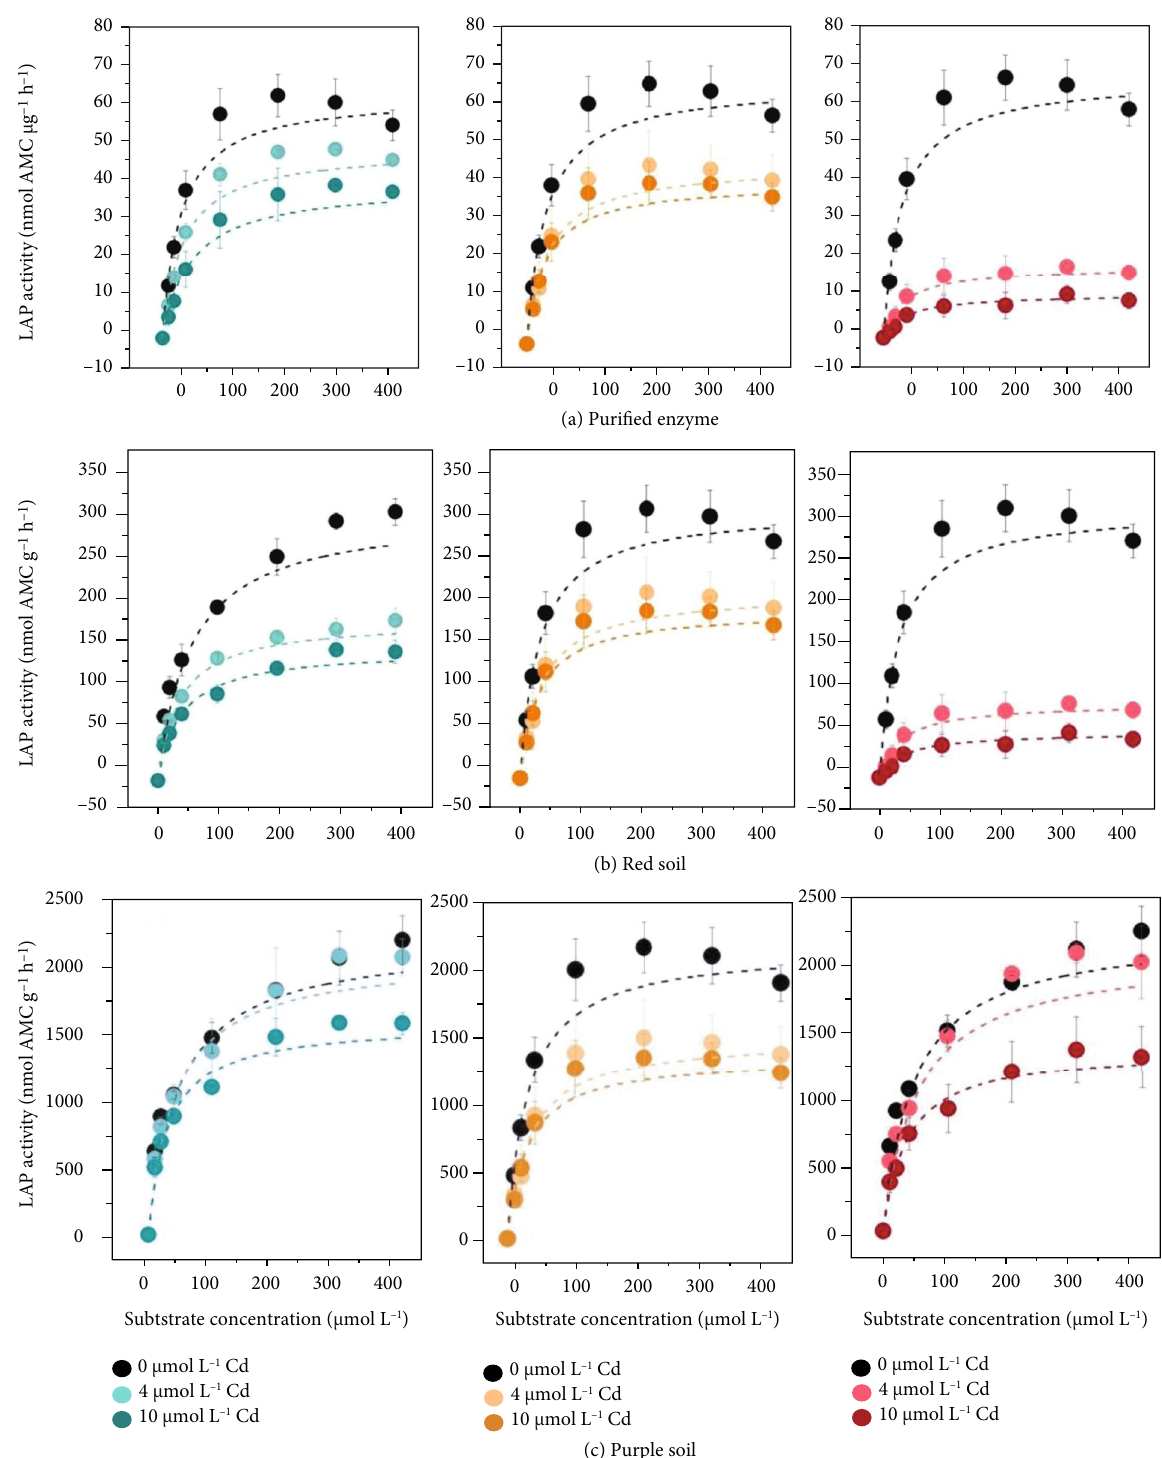
Figure 2: Kinetic pro fi les of puri fi ed enzyme, red soil LAP, and purple soil LAP a ff ected by 0, 4, and 10 μ mol Cd, Ag, and Hg,